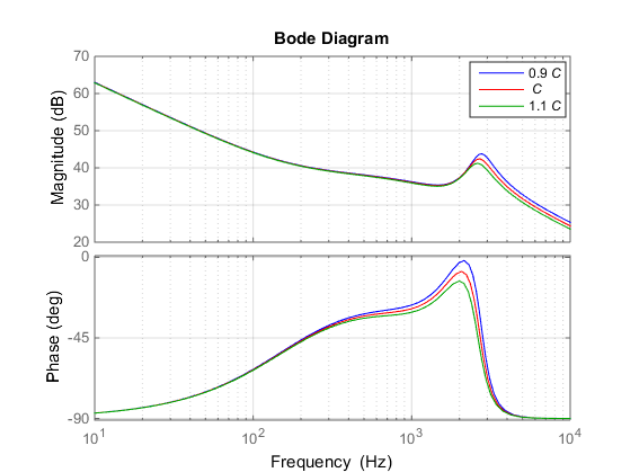
Fig. 8. The inverter output impedance sensitivity to capacitance